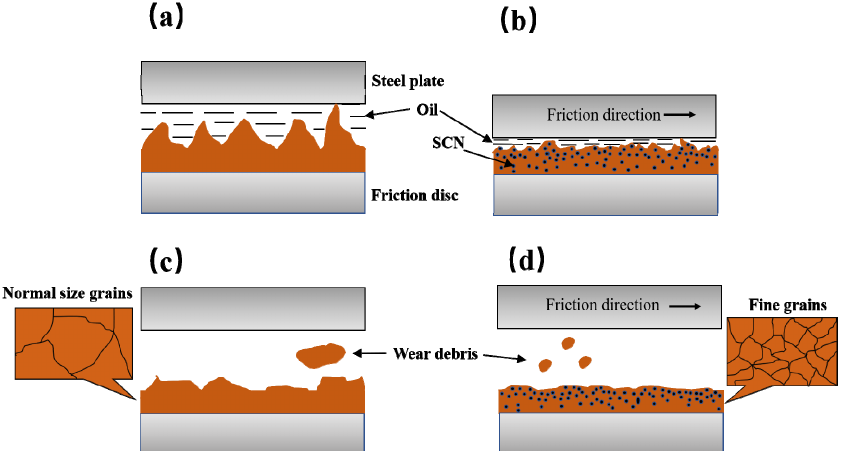
Figure 15. Schematic diagram of friction surface morphology, the pre-test surface of CBFM-A ( a ) and CBFM-B ( b ), the post-test surface of CBFM-A ( c ) and CBFM-B ( d ).